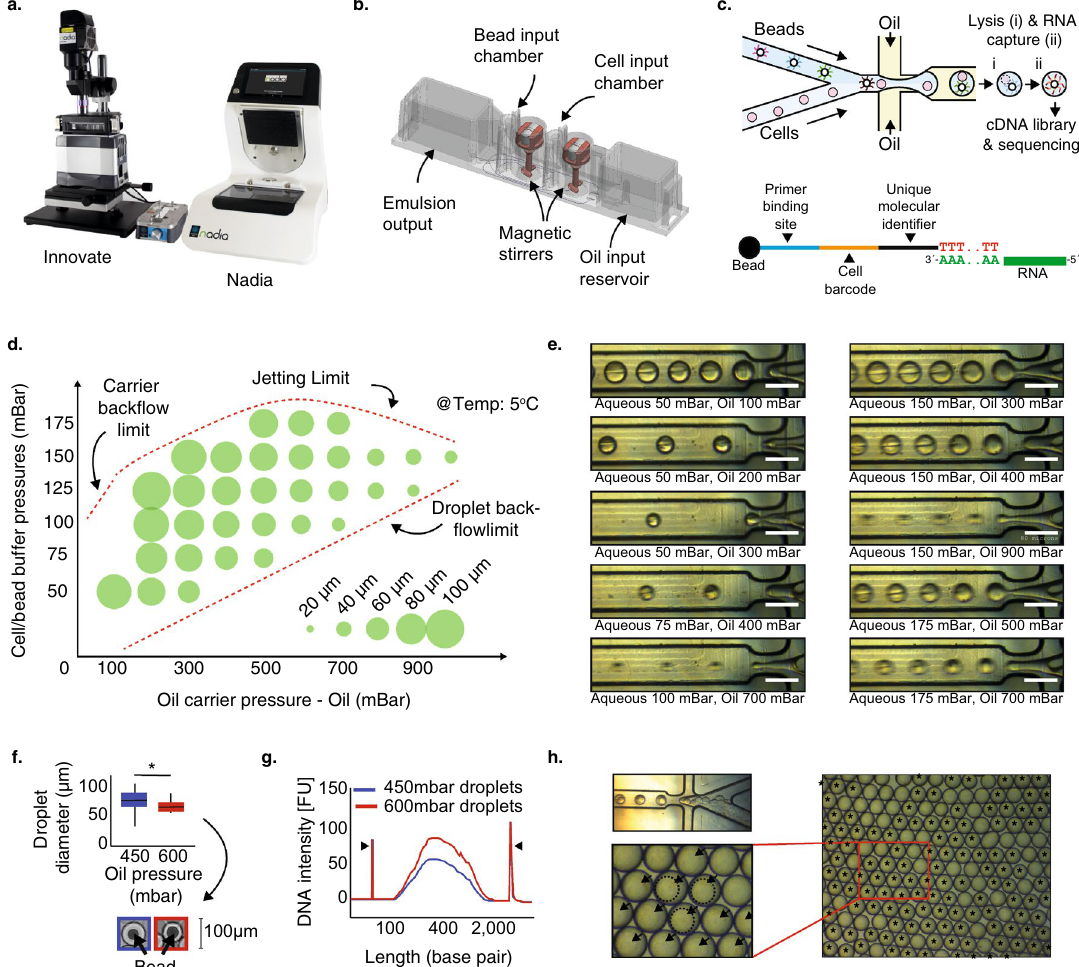
Figure 1. An open platform for single cell transcriptome profiling. ( a ) The Nadia Instrument (right) and Nadia Innovate (left) benchtop platform for single-cell transcriptomics. ( b ) Design of the disposable microfluidics cartridge used in the Nadia. ( c ) Schematic of the droplet sequencing workflow used in the Nadia platform. In brief, single cells or nuclei are encapsulated in aqueous droplets in oil together with barcoded beads. Following lysis within droplets the released mRNA is captured upon the bead and provided both a cell barcode and a unique molecular identifier. Beads are subsequently pooled prior to reverse-transcription and generation of cDNA libraries called “single-cell transcriptomes attached to microparticles” (STAMPs). The barcoded STAMPs are then amplified in pools for high-throughput RNA-seq. ( d ) Theoretical variation of droplet size by changing oil and liquid stream pressures. ( e ) Experimental variation of droplet size by changing oil and liquid stream pressures. White scale bars represent 100 μm. ( f ) Stable droplet diameters at different oil pressures. Inset shows example droplets containing non-deformable beads. ( g ) Bioanalyser traces of full-length transcript PCRs amplified from identical bead numbers but different droplet dimensions. ( h ) Example image of deformable beads captured with the Nadia system. Upper left panel shows crowding of deformable beads behind microfluidics junction, lower left panel shows droplet occupancy following sychronised deformable bead loading. For reader guidance, outlines of three deformable beads are indicated with dashed lines, and droplets containing beads are marked by black arrowheads. Right panel shows zoomed out image revealing > 70% droplet occupancy of deformable beads. For reader guidance, all droplets containing a deformable bead are marked by a black